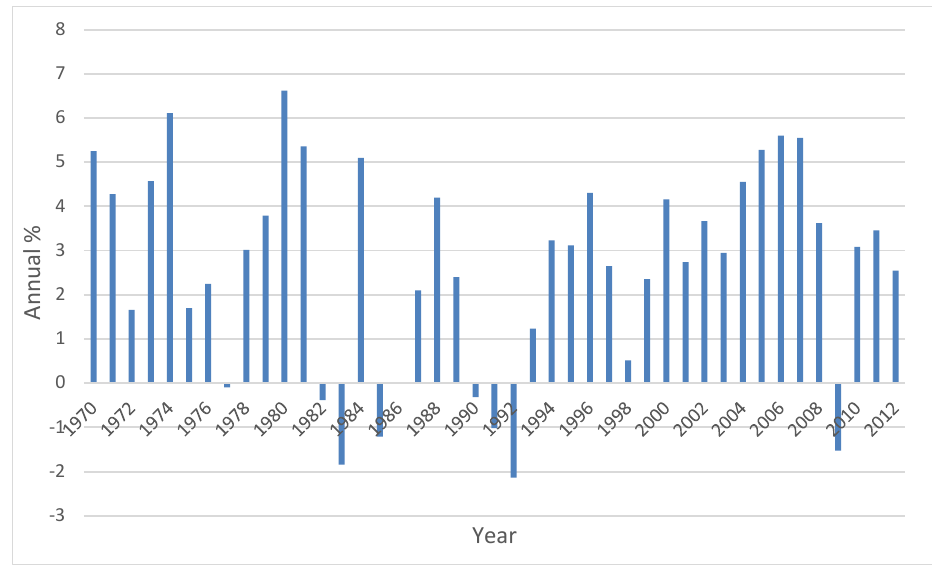
FIGURE 2: GDP growth rate in South Africa (1970-2012) Source: Authors’ calculations based on World Bank WDI database